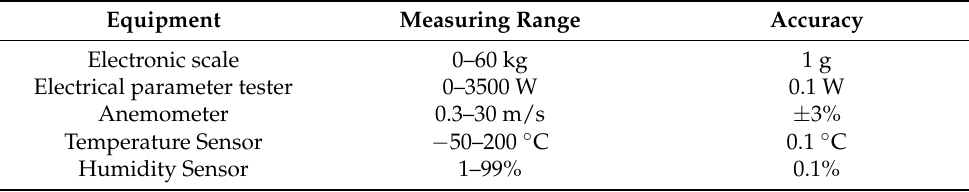
Table 4. Basic Parameters of Typical Cities in Five Climate Zones of